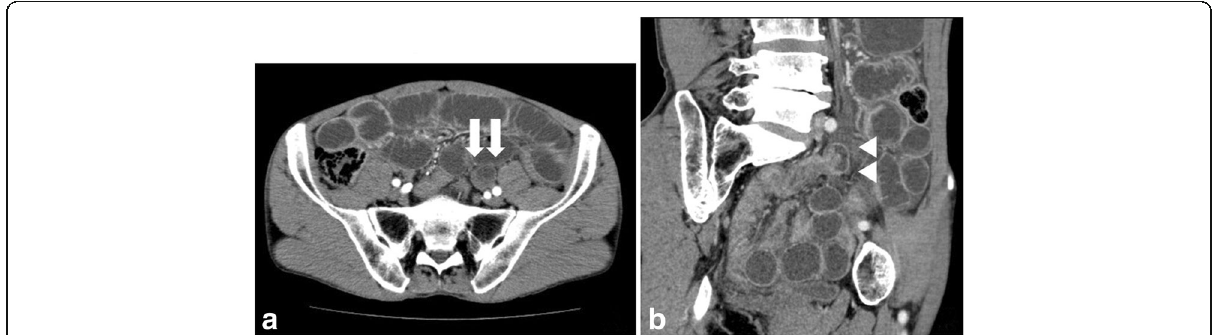
Fig. 1 Abdominal computed tomography (CT) scan showing small bowel obstruction . a Axial section (white arrows). b Coronal section (white